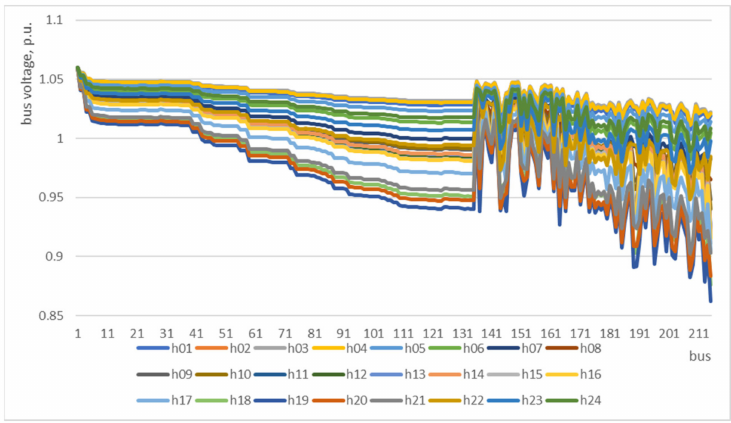
Figure 26. The bus voltages in the 215-bus network without compensation, for each hour from the analyzed day.